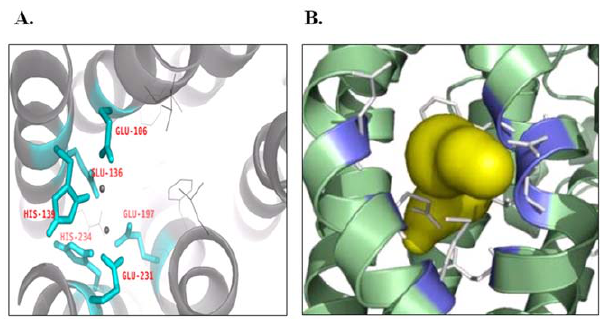
Figure 3. Homology modeling and identified substrate tunnel. A. The residues involved in coordinating dinuclear iron. These residues were labeled in cyan, and the dinuclear iron sites were shown in sphere; B. Tunnel identified in the homology modeling of PHN component from Arthrobacter sp. W1 using CAVER. The white sticks represent five formed residues, i.e. Thr-201, Asn-202, Phe-205, Glu-231 and Met-235. The tunnel is labeled as yellow surface and the residues formed entrance are in